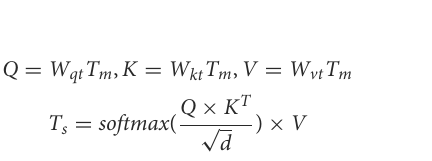
FIGURE5 The scaled Dot-Production attention module. First, calculate the attention scores of Q and K , then use softmax to normalize the calculated attention weight scores, and finally weight the scores and V to obtain the final attention